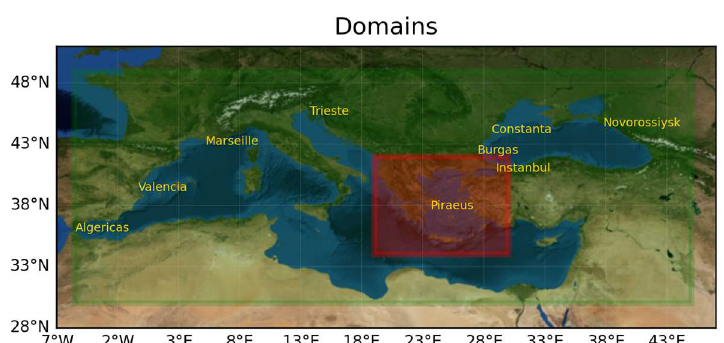
Figure 1. The Mediterranean and Black Seas studied in this work (green box) as well as the Greek sub-domain (red box) (Created using background ArcGIS ® ).